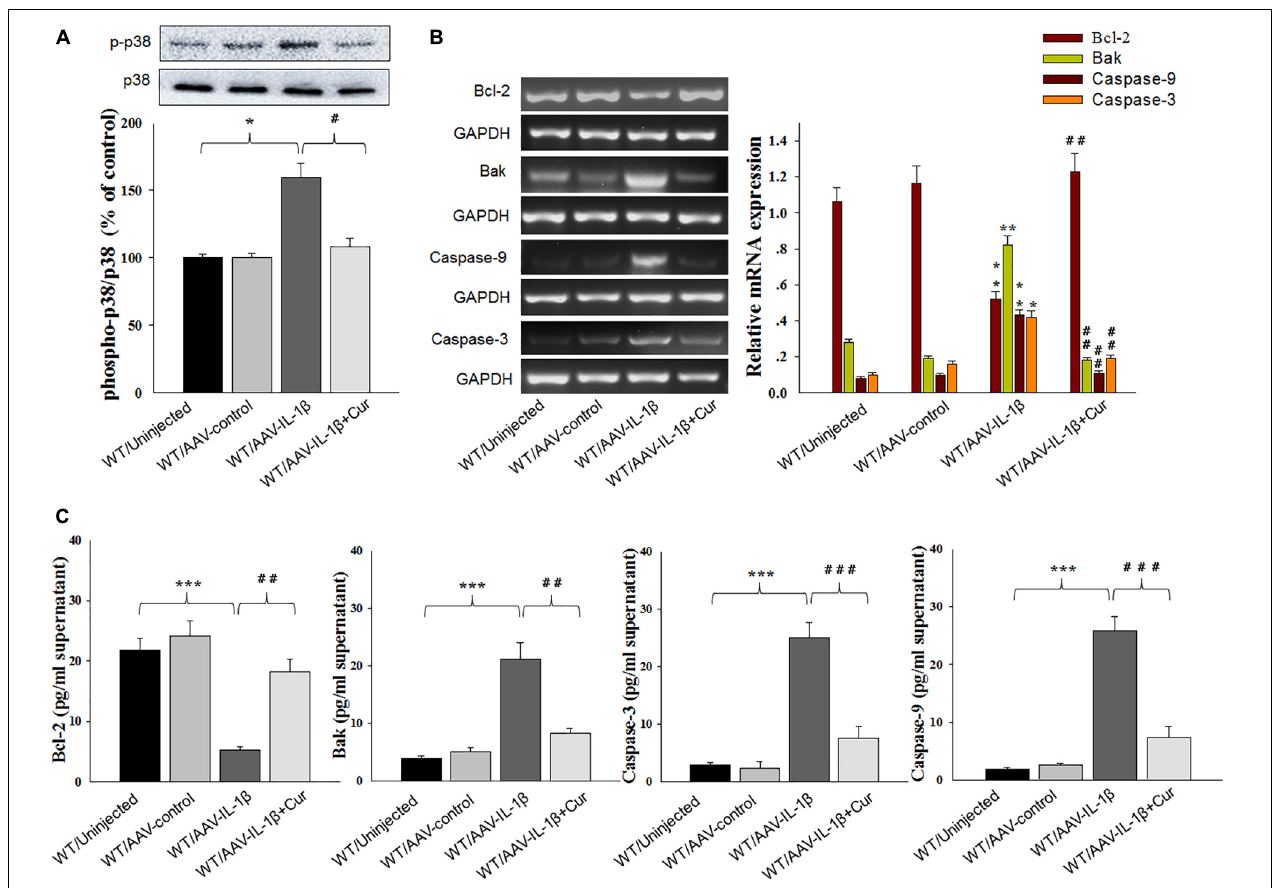
FIGURE 6 | Curcumin attenuated apoptosis-related factors expression caused by IL-1 β overexpression. (A) Phosphorylation levels of p38 MAPK in the vmPFC infected with the AAV-IL-1 β virus. (B) RT-PCR assays of expression levels of Bcl-2, Bak, Caspase 3 and Caspase 9 in vmPFC neurons infected with AAV-IL-1 β . (C) ELISA assays of expression levels of Bcl-2, Bak, Caspase 3 and Caspase 9 in vmPFC neurons infected with AAV-IL-1 β . N = 6/group. ∗ P < 0.05, ∗∗ P < 0.01, ∗∗∗ P < 0.001 WT + AAV-IL-1 β vs. WT rats. # P < 0.05, ## P < 0.01, ### P < 0.001 WT + AAV-IL-1 β + Cur vs. WT + AAV-IL-1 β